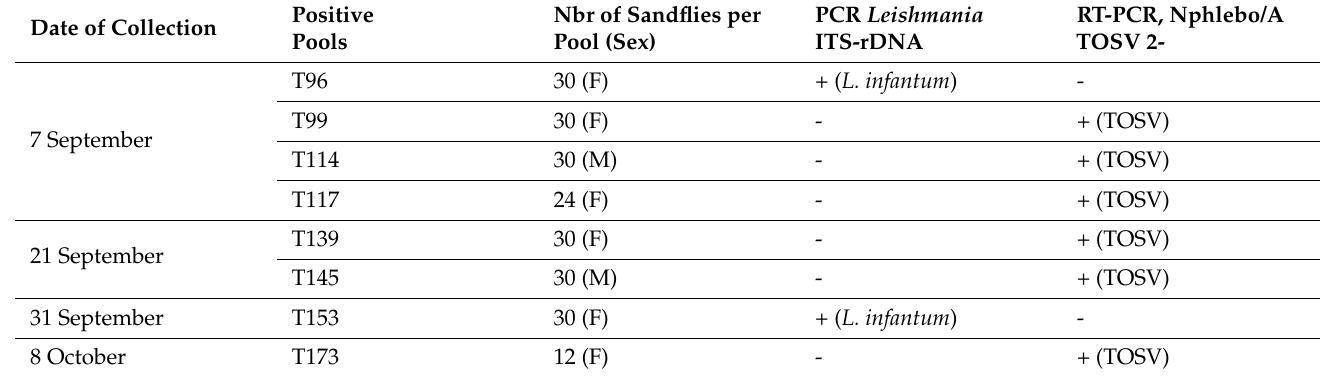
Table 2. Detection of TOSV and L. infantum infections in field-collected sandflies from the exposure